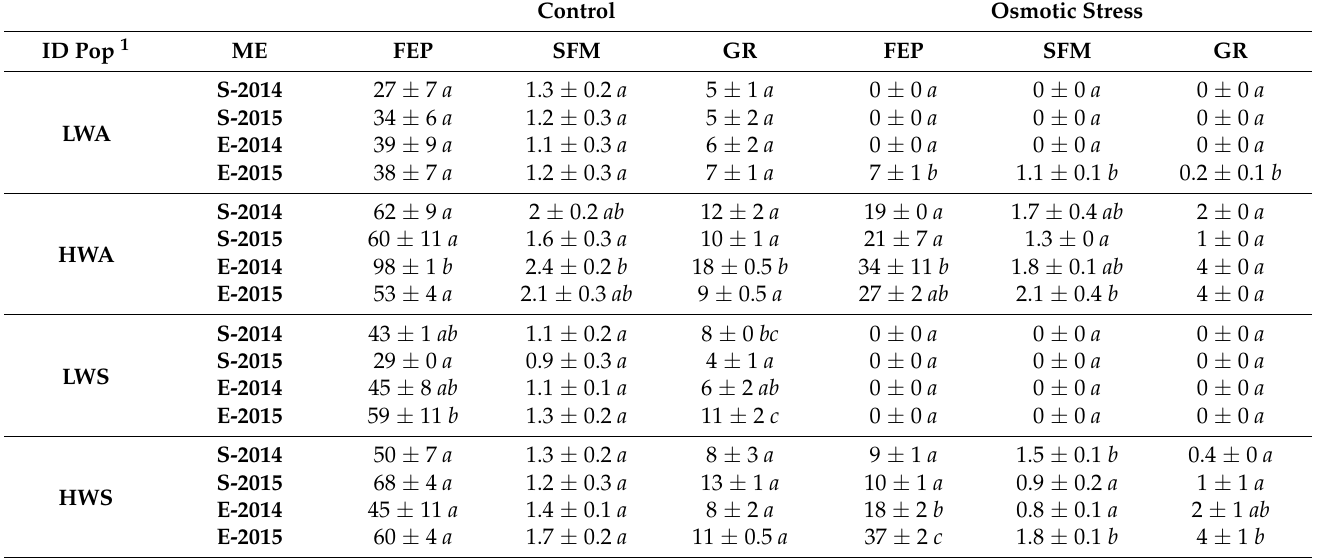
Table 2. Mean values ( ± standard error) of final emergence percentage (FEP), seedling fresh mass (SFM) and Maguire’ germination rate (GR) for Leptochloa crinita populations and maternal environ- ment (ME) of seeds evaluated under osmotic and non-osmotic stress. Control Osmotic